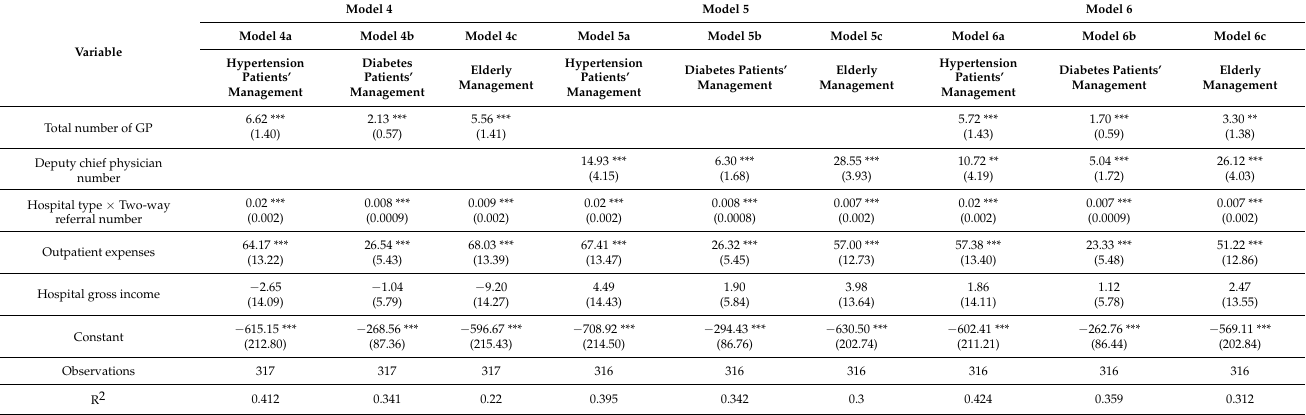
Table 9. Results of the robustness test carried out on Model 4–Model